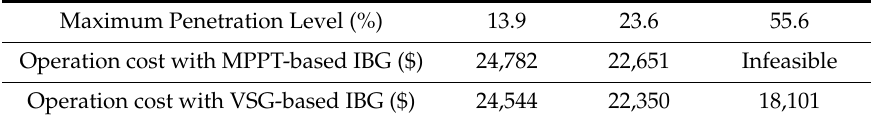
Table 9. Predicted renewable generation and